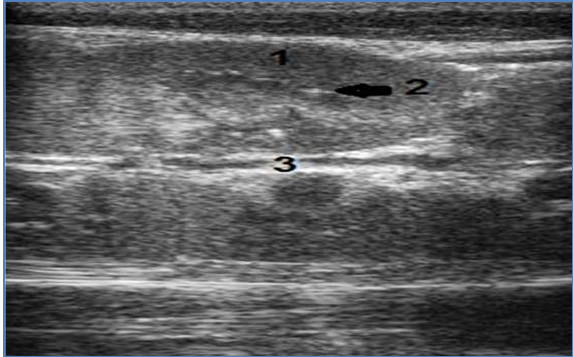
Figure, 5: Transrectal ultrasonogram of left kidney of buffalo 6.5 MHz. 1=cortex, 2=arcuate arteries,